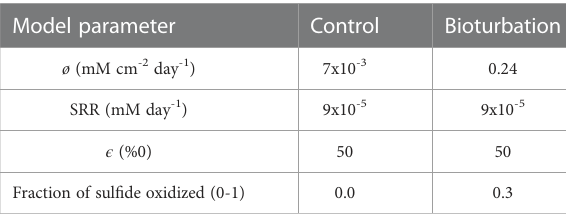
TABLE 1 Model parameters for control experiment and experiment with bioturbation. Model